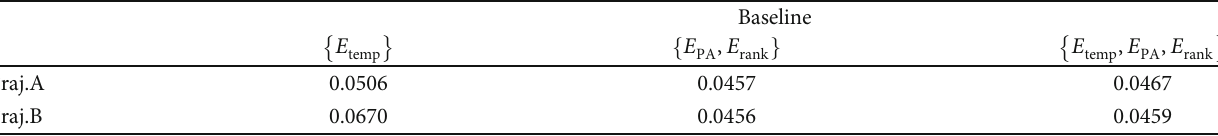
on baseline. 3 D